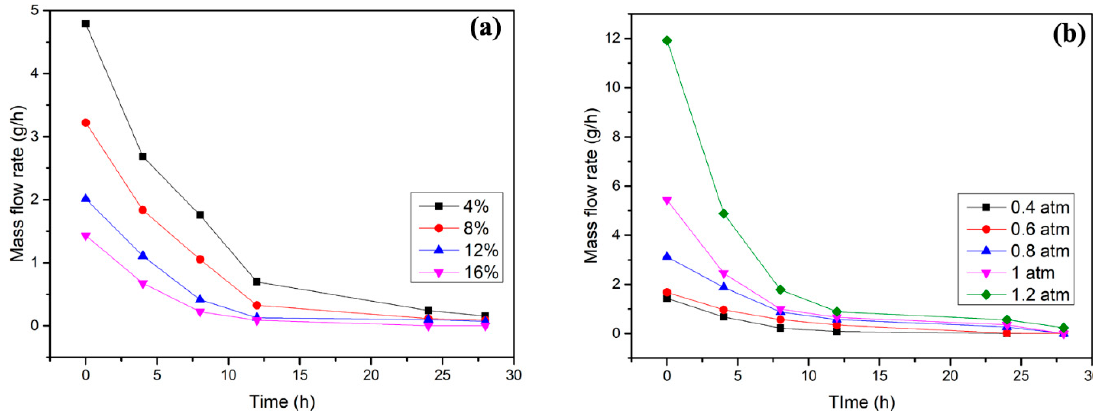
Figure 13. Water flow through single crack in the cement core for ( a ) various dosage of DPAM at 0.4 atm differential pressure ( b ) various differential pressures for 16% dosage DPAM cement core.